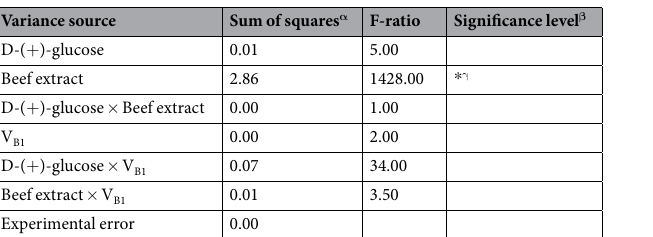
Table 12. Variance analysis of the L 8 (2 7 ) orthogonal experiment on the optimisation of the culture medium. α The degree of freedom in this experiment was 1, and the mean square of each factor was the same as the sum